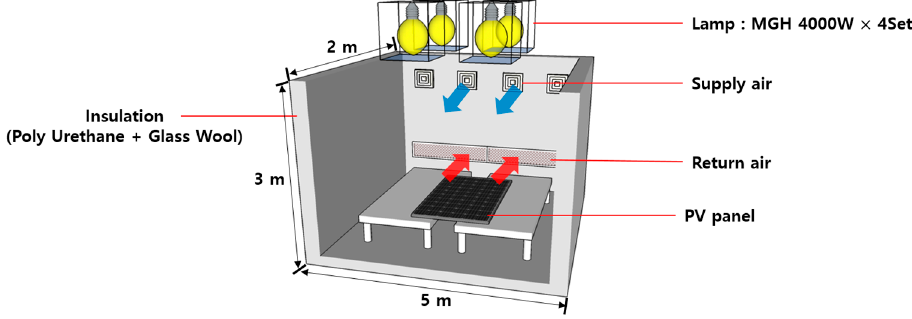
Figure 3. Solar simulator for indoor test (International Eletrotechnical Commission